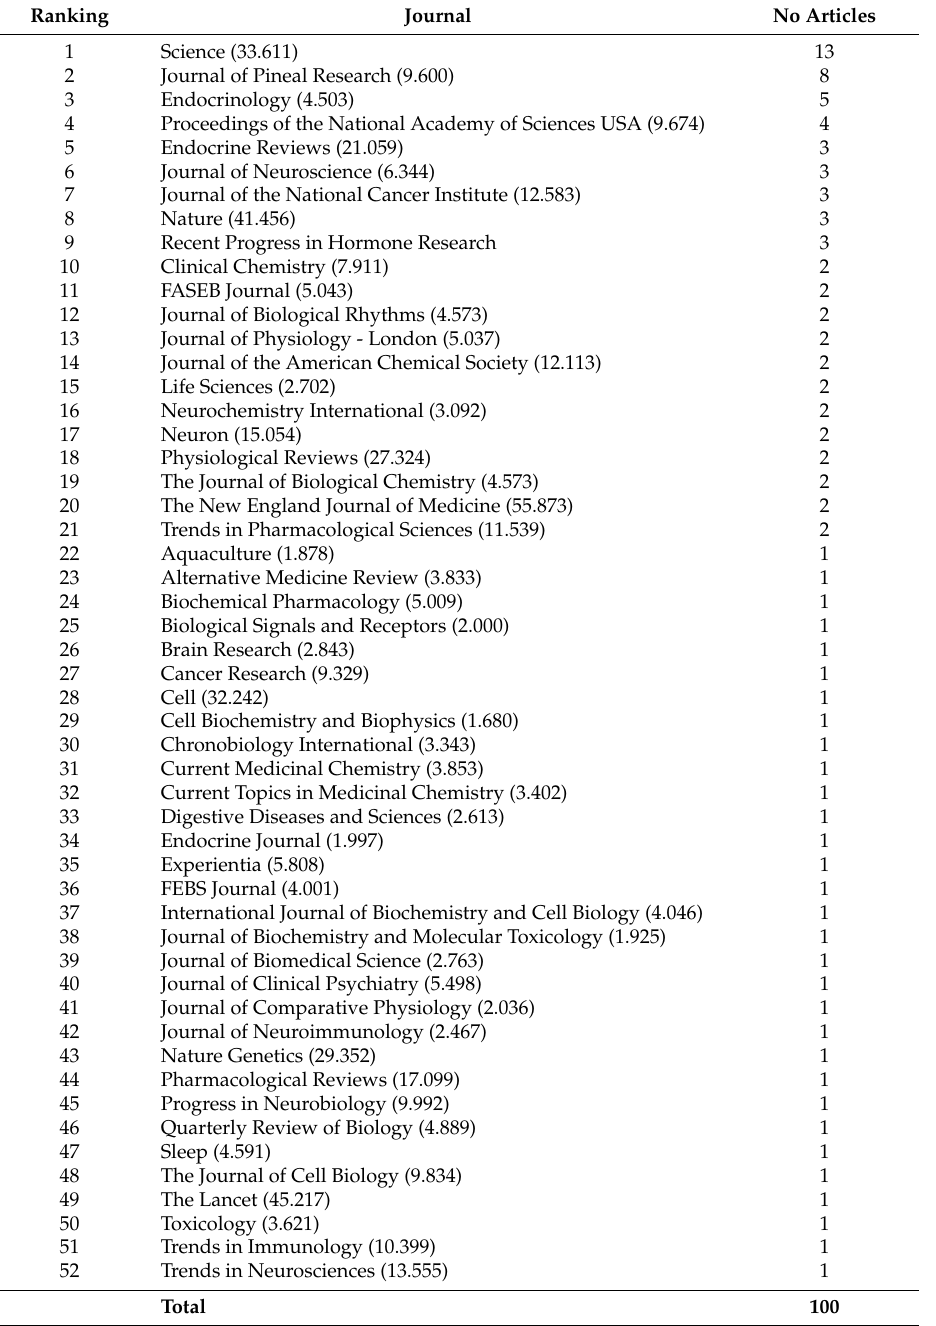
Table 5. Ranking of the journals with articles within the top 100